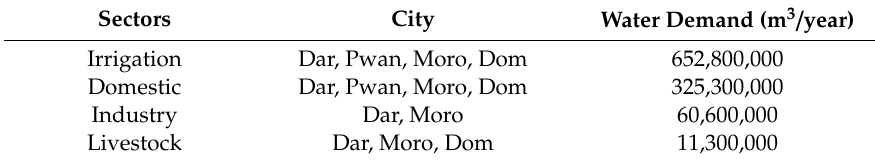
Figure 4. The impact of the various scenarios on ( a ) growth in water demand and ( b ) surface runoff trends. Table 2. Sectorial water demand in the Wami Ruvu basin. Table 2. Sectorial water demand in the Wami Ruvu